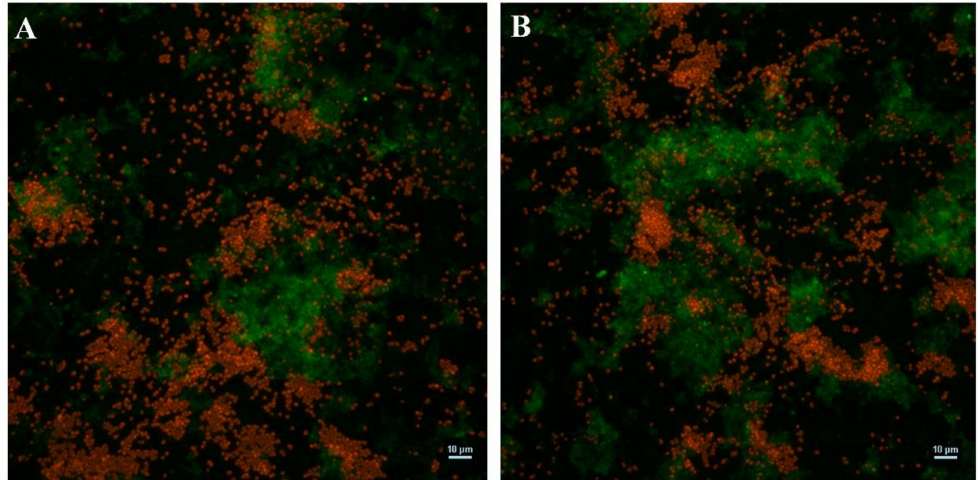
Figure 2. Maximum fluorescence Z projections of confocal laser scanning microscopy (CLSM) images of biofilms grown for 21 days in ( A ) medium enriched with inorganic carbon and ( B ) non-enriched medium. Red: Chlorophyll autofluorescence; green: EPS dyed with ConA-Texas